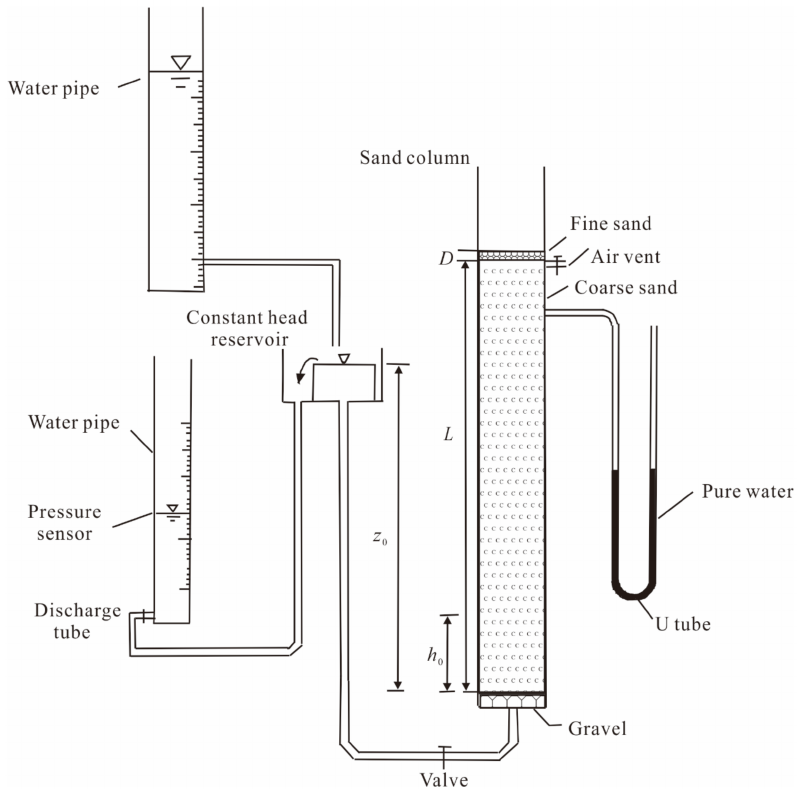
Figure 2. Schematic diagram of setup for the injection experiment with constant head sources. Modified from Dong et al. [37].